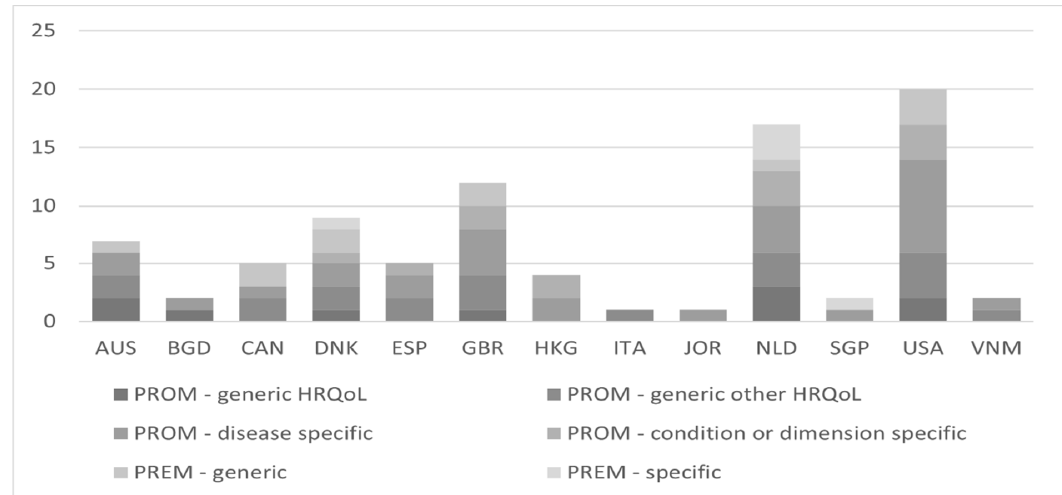
Figure 2. Number of PROMs and PREMs used in studies by country.